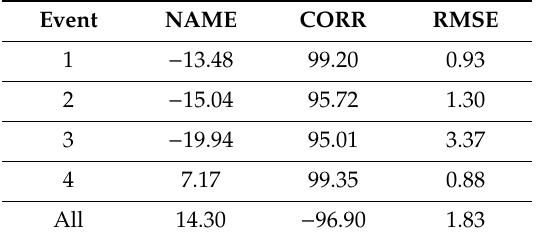
Table 3. Comparison results of hourly rainfall between the EWRG and ground-based equipment (Pit- Gauge, Tipping gauge).